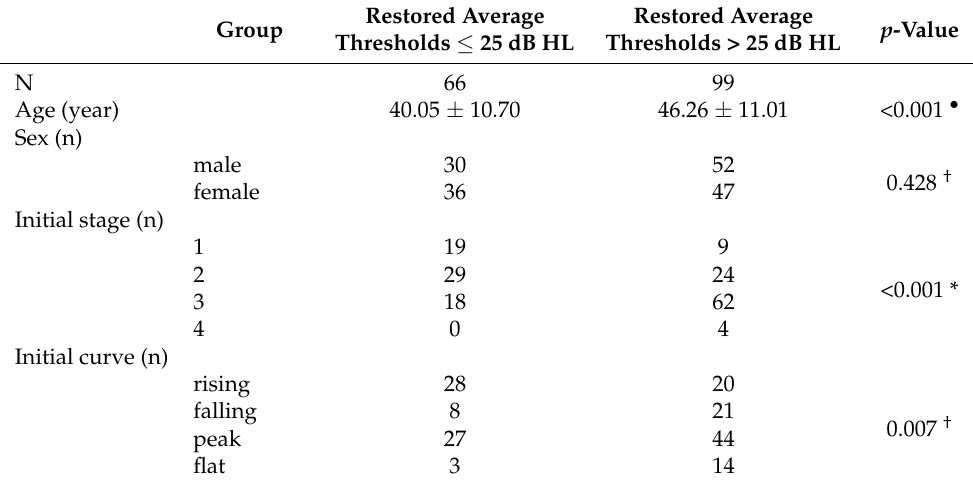
Table 3. The comparison between different hearing results of the patients after clinical management.